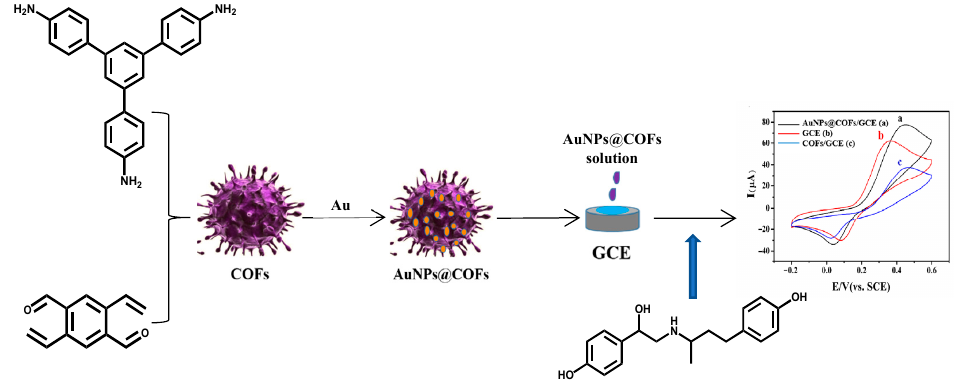
Figure 1. Preparation and sensing principle diagram of AuNPs@COFs nanocmposites.